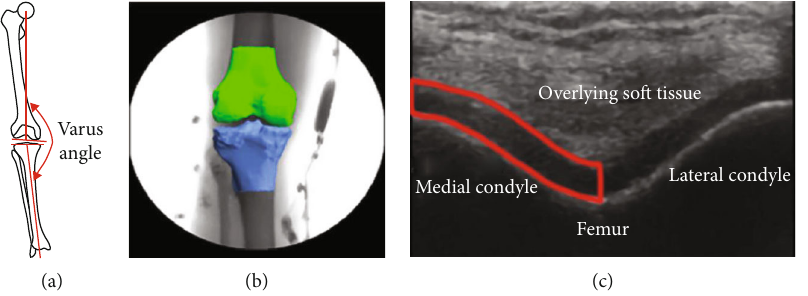
Figure 6: The morphological parameters of a knee joint. (a) Knee varus angle [23]. (b) Dynamical knee joint space [62]. (c) Ultrasonographic image of the femoral articular cartilage with the medial compartment cross-sectional area [64].